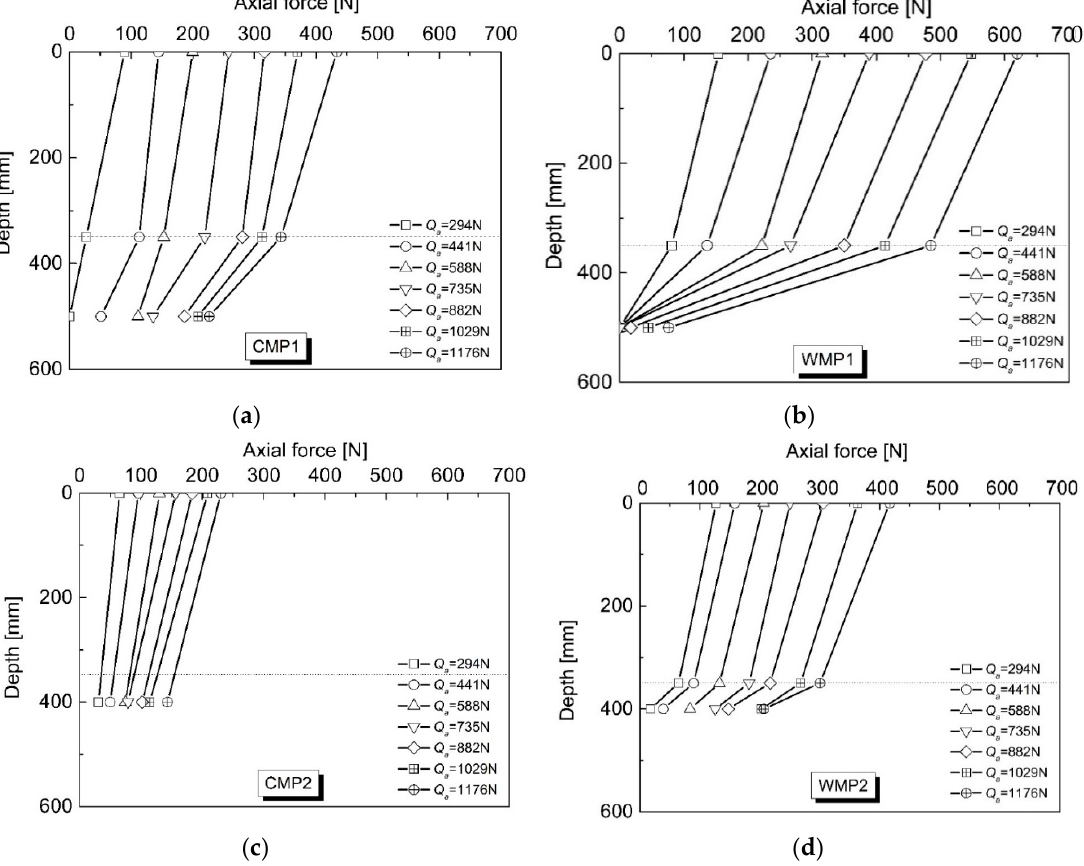
Figure 8. Load transfer behavior of different types of micropile subjected to additional loads. ( a ) CMP1; ( b ) WMP1; ( c ) CMP2; and ( d ) WMP2.